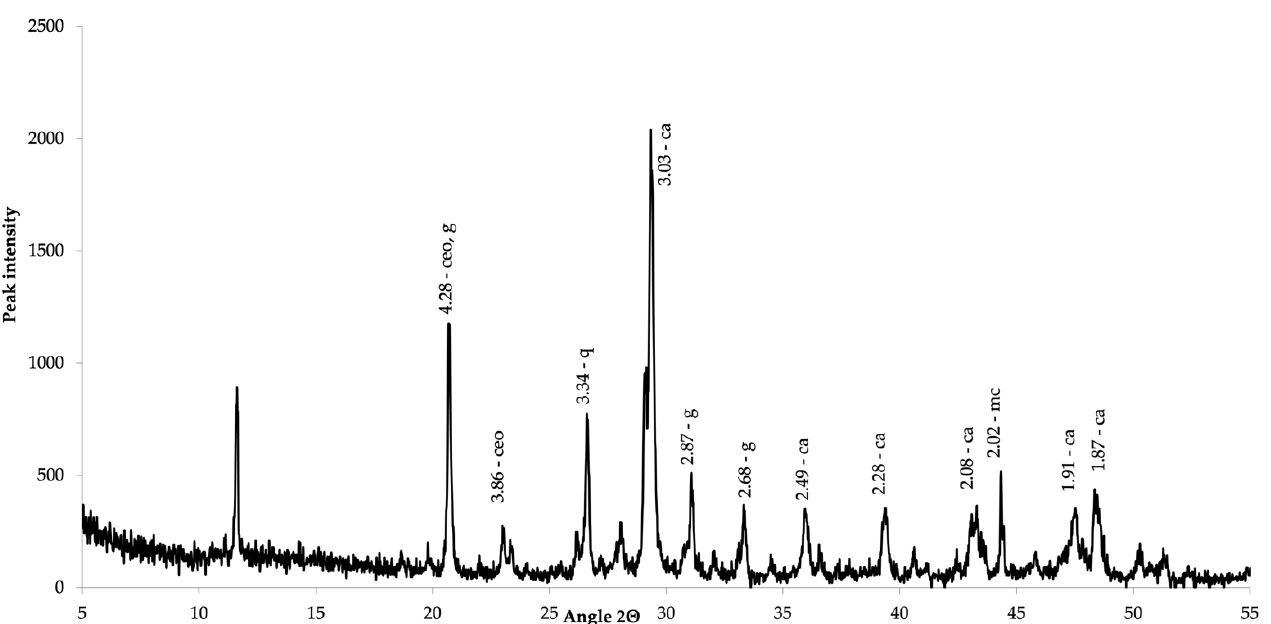
Figure 7. X-ray of a sample from the wall of the Sukhum fortress—Sukhum-kale (architect Yusuf-aga, 1724).